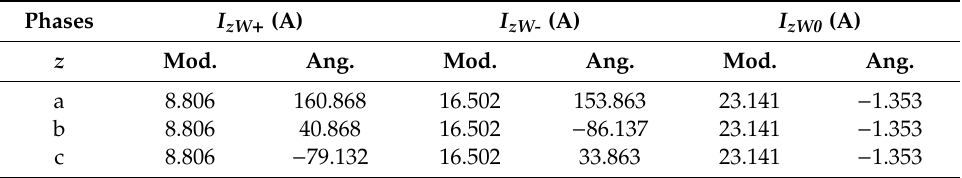
Table 3. Positive-, negative-, and zero-sequence currents that consume the ZSCC compensator.